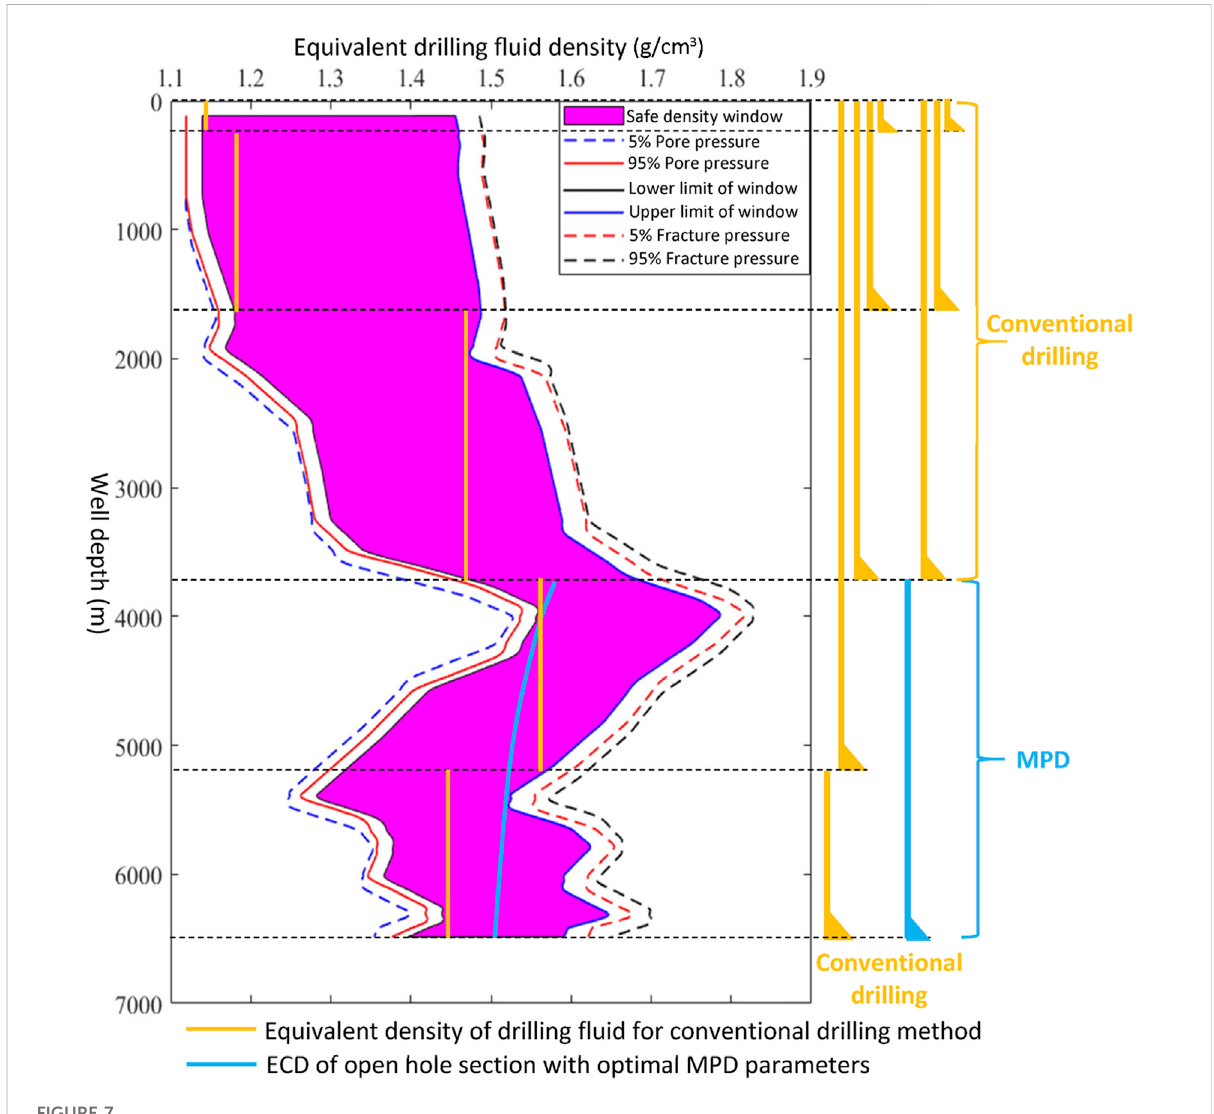
FIGURE 7 Calculation fl ow chart of controlled pressure matching formation